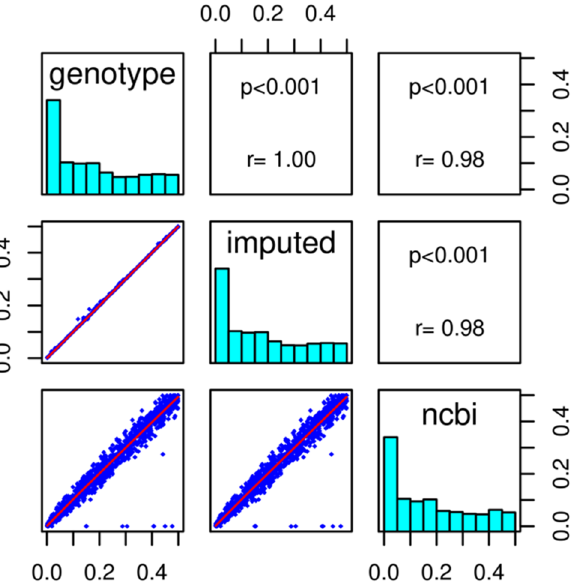
Figure 1. Correlations between the MAFs of genotyped, imputed variants and those of the NCBI dbSNP B137. In the absence of pre-filtration only 13 SNPs were not correlated with NCBI dbSNP B137.